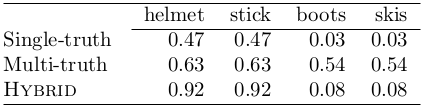
Table from the paper: Discovering Multiple Truths with a Hybrid Model
Table text:
helmet
stick
boots
skis
Single-truth
0.47
0.47
0.03
0.03
Multi-truth
0.63
0.63
0.54
0.54
Hybrid
0.92
0.92
0.08
0.08